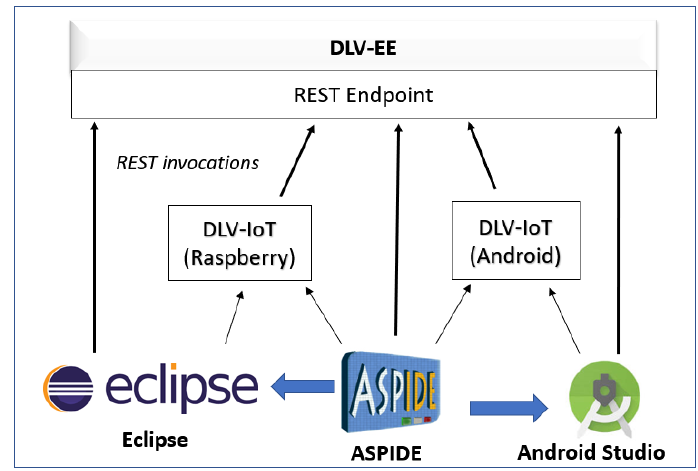
Figure 3. Integrated Development Environment for DLV-EE and